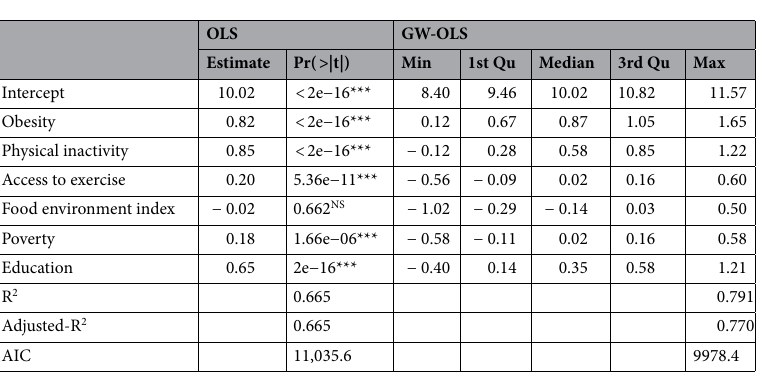
Table 1. Summary results of ordinary least square (OLS) and geographically weighted ordinary least squares regression (GW-OLS) models. OLS: ordinary least square s , GW-OL S , geographically weighted OLS regression, AIC: Akaike’s information criterion. ***p < 0.001, NS: not